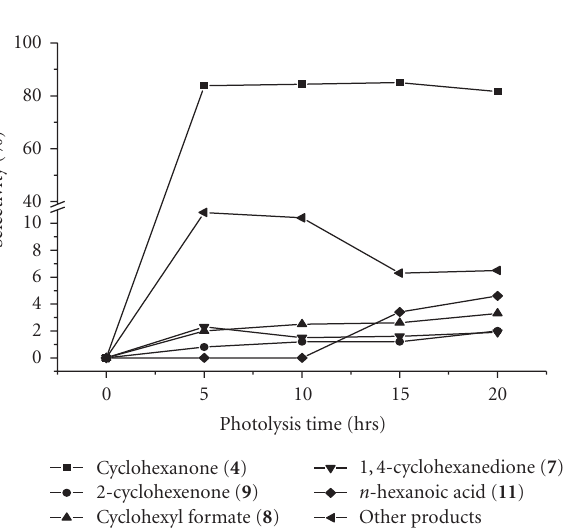
Figure 3: Selectivity of products of PCO of 1 in